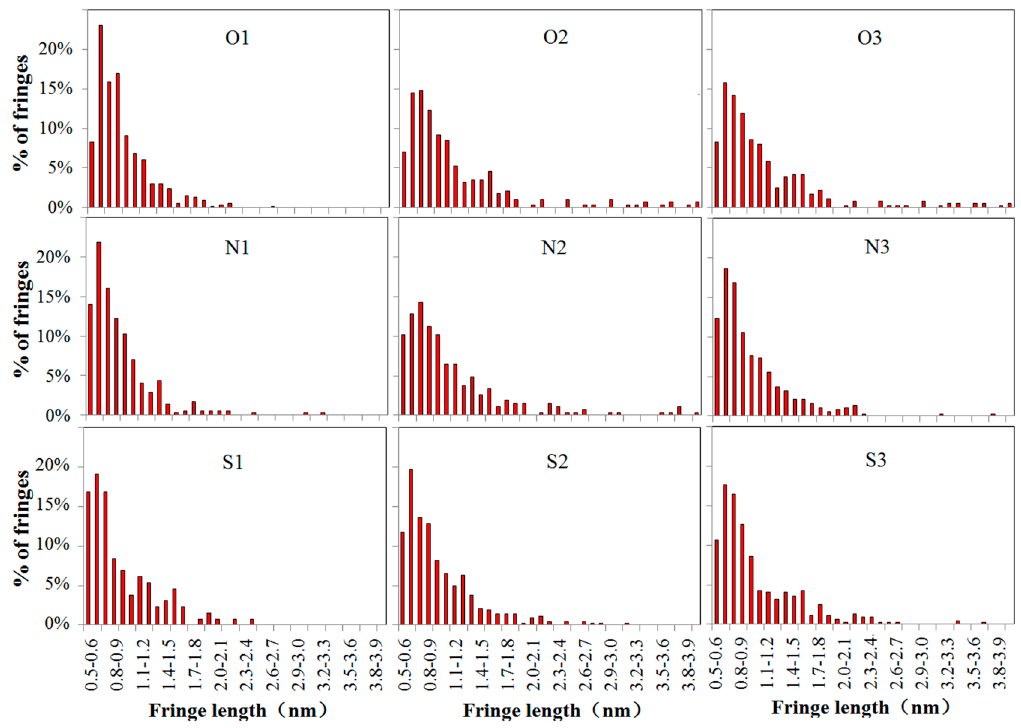
Figure 7. Fringe length histograms analyzed by the HRTEM image analysis algorithms from skeletonized images in Figure 6.